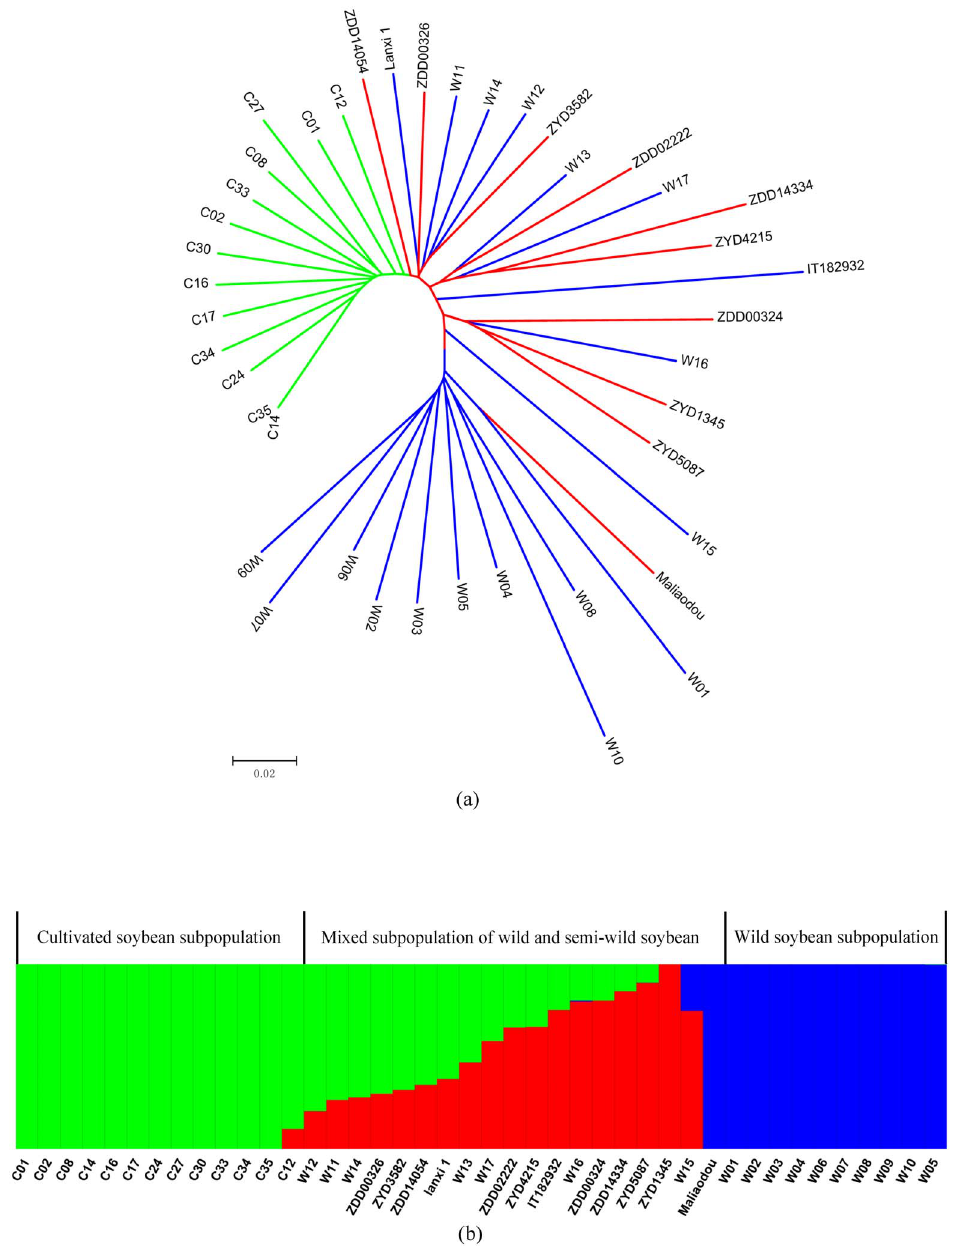
Figure 3. Phylogenetic tree and population structure of wild, semi-wild, and cultivated soybeans. (a) A neighbor-joining phylogenetic tree constructed using SNP data. Cultivated, semi-wild, and wild soybeans are labeled with green, red, and blue lines, respectively. (b) Bayesian clustering (STRUCTURE, K =3) of soybean accessions were grouped based on their species. Cultivated lines were designated with ‘C’ as prefix while wild lines were with ‘W’ as prefix except IT182932 (Korean) and Lanxi 1 (this study). Semi-wild lines were titled with ‘Z’ as prefix except Maliaodou.